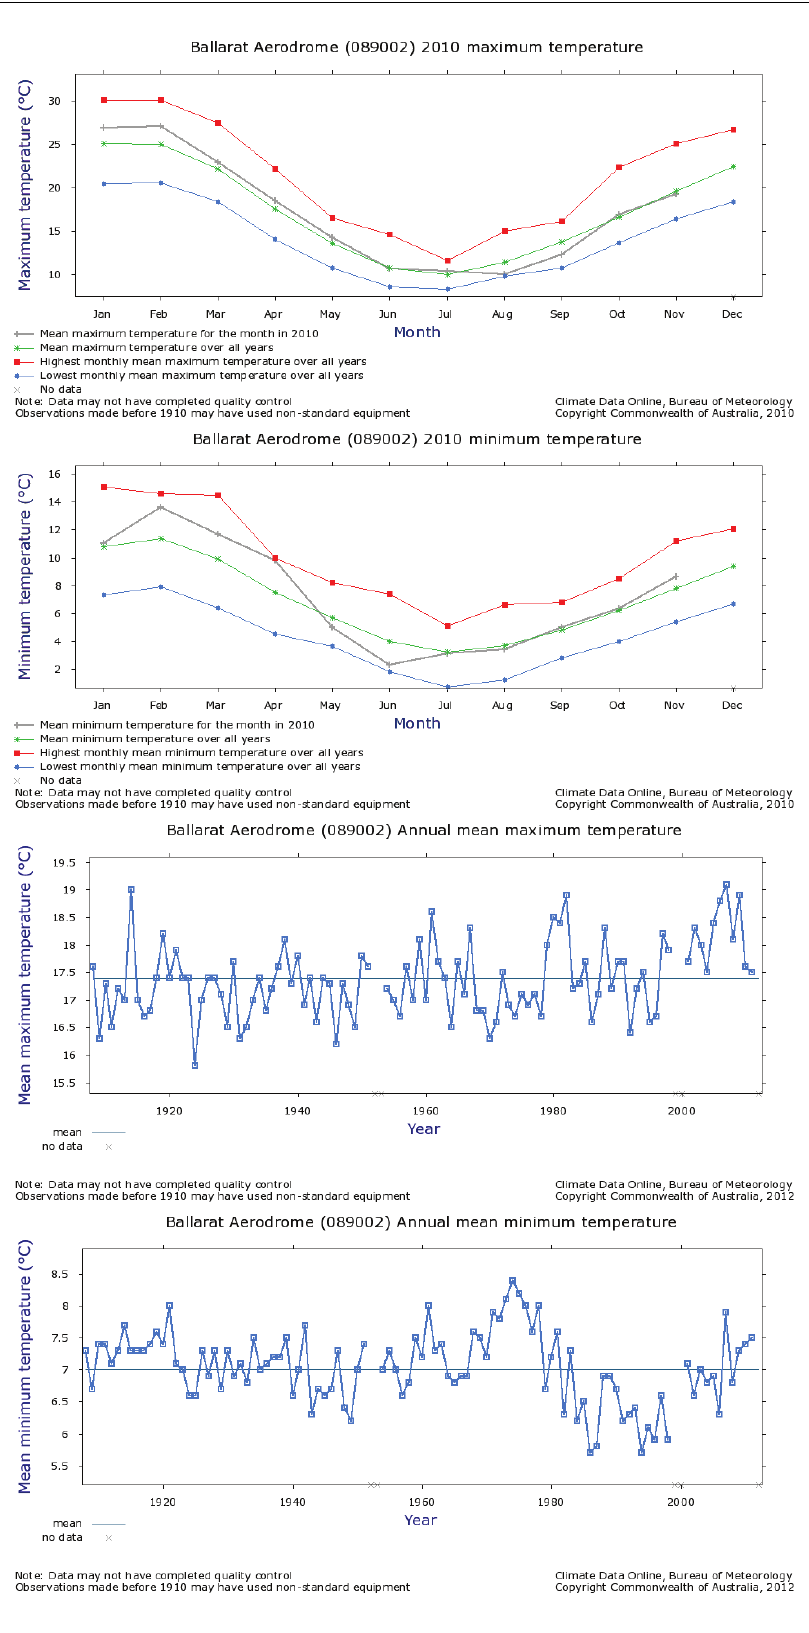
Figure 13. Australian Government Bureau of Meteorology temperature graphs for historical locations in Victoria, Aus-